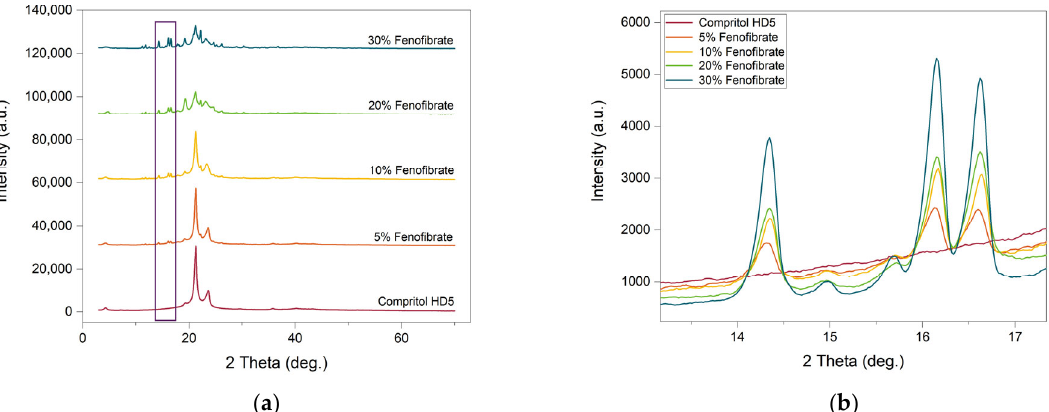
Figure 4. X ‐ ray powder diffraction curves. ( a ) Mixture of the two at 5%( w / w ), 10%( w / w ), 20%( w / w ) and 30%( w / w ). ( b ) Figure 4. X-ray powder diffraction curves. ( a ) Mixture of the two at 5% ( w / w ), 10% ( w / w ), 20% ( w / w ) and 30% ( w / w ). Region of interest corresponding to the Fenofibrate characteristic peaks. ( b ) Region of interest corresponding to the Fenofibrate characteristic